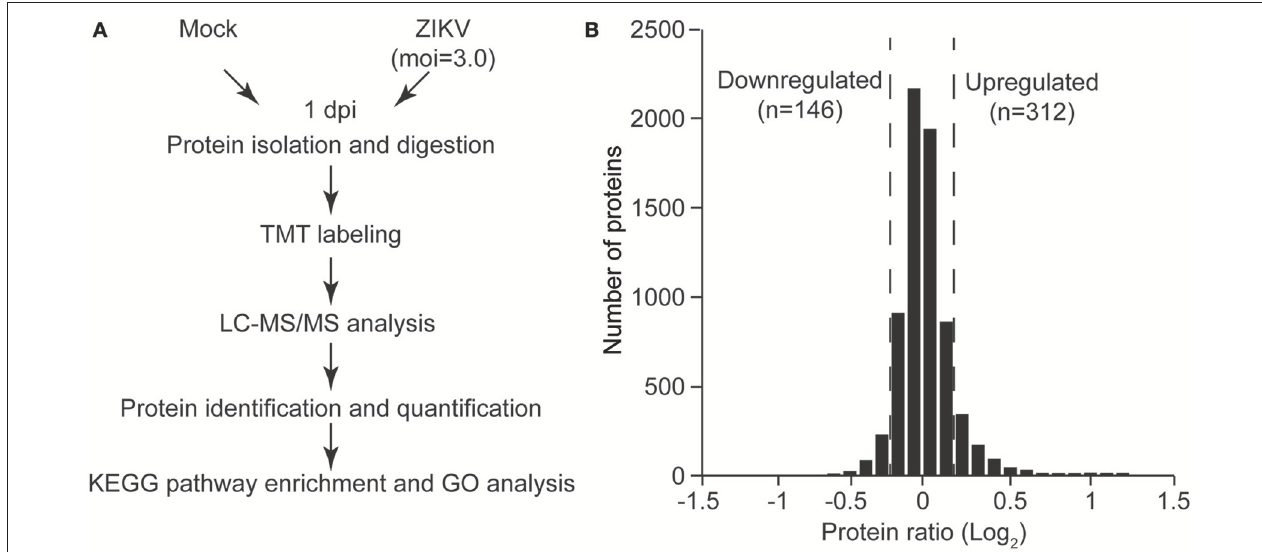
FIGURE 2 | Quantitative proteomic analysis of ZIKV-infected NPCs. (A) Schematic of quantitative proteomic analysis of ZIKV-infected NPCs. Briefly, NPCs were infected with ZIKV at an MOI of 3 or mock infected, and were harvested at 1 dpi for protein isolation and digestion. After TMT labeling, the digested peptides were subjected to LC-MS/MS analysis. Proteins were identified and quantified via bioinformatic analysis. KEGG pathway enrichment and GO analysis were performed on differentially regulated proteins. (B) Gaussian distribution of measured protein ratios. The proteins with ratios higher than 1.2-fold or lower than 0.8-fold were considered to be differentially